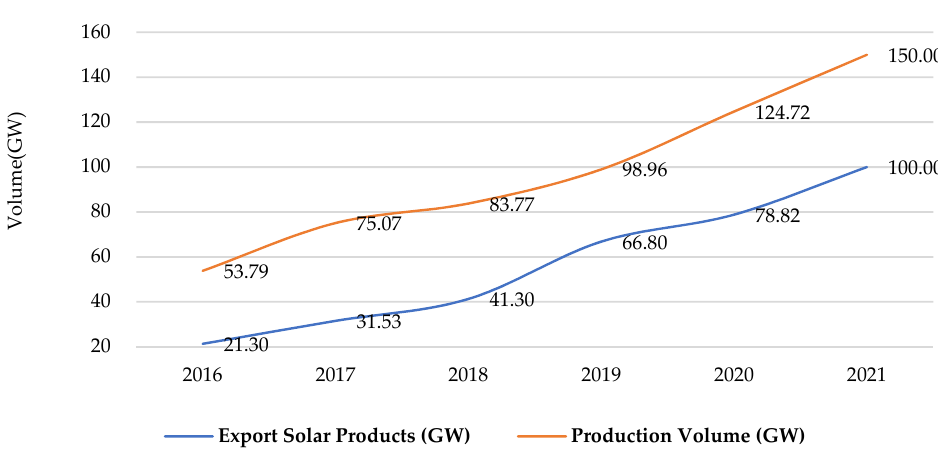
Figure 5. Export volume of solar PV products in 2016–2020. Source: China Photovoltaic Industry Association (CPIA) [66].